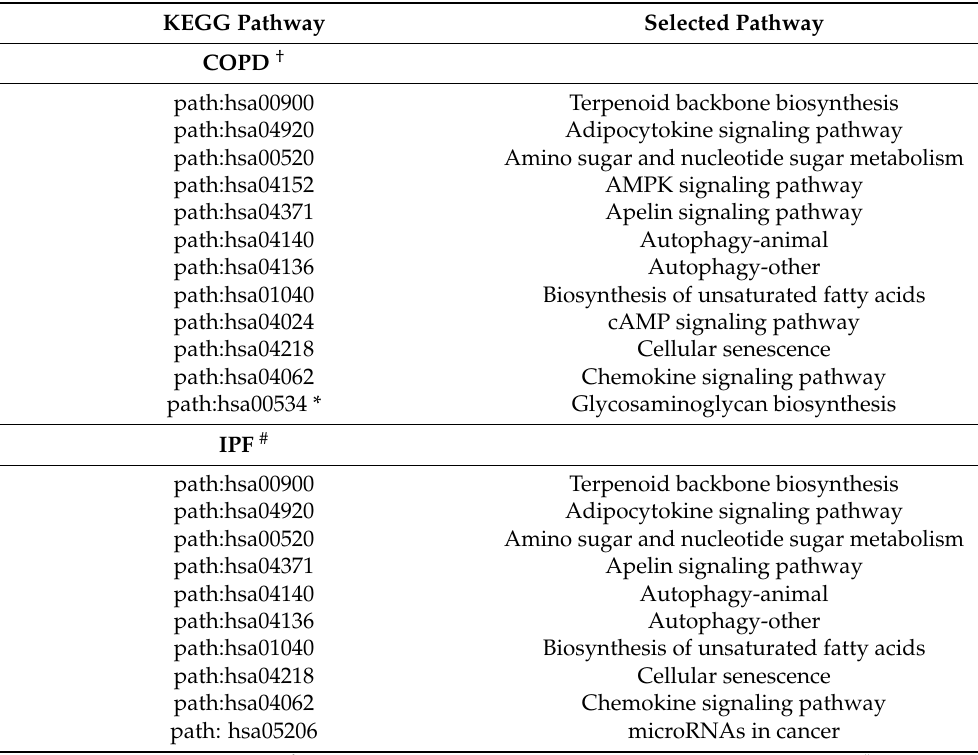
Table 3. KEGG analyses of differentially expressed miRNAs in BALF-derived exosomes from COPD and IPF